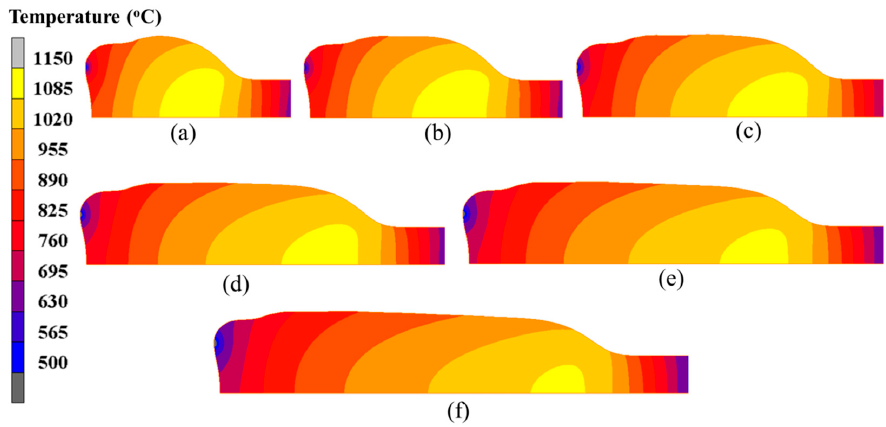
Figure 18. Temperature field distributions of the billet at different electric upsetting moments: ( a ) 750 s, ( b ) 1000 s, ( c ) 1250 s, ( d ) 1500 s, ( e ) 1750 s and ( f ) 2000 s.